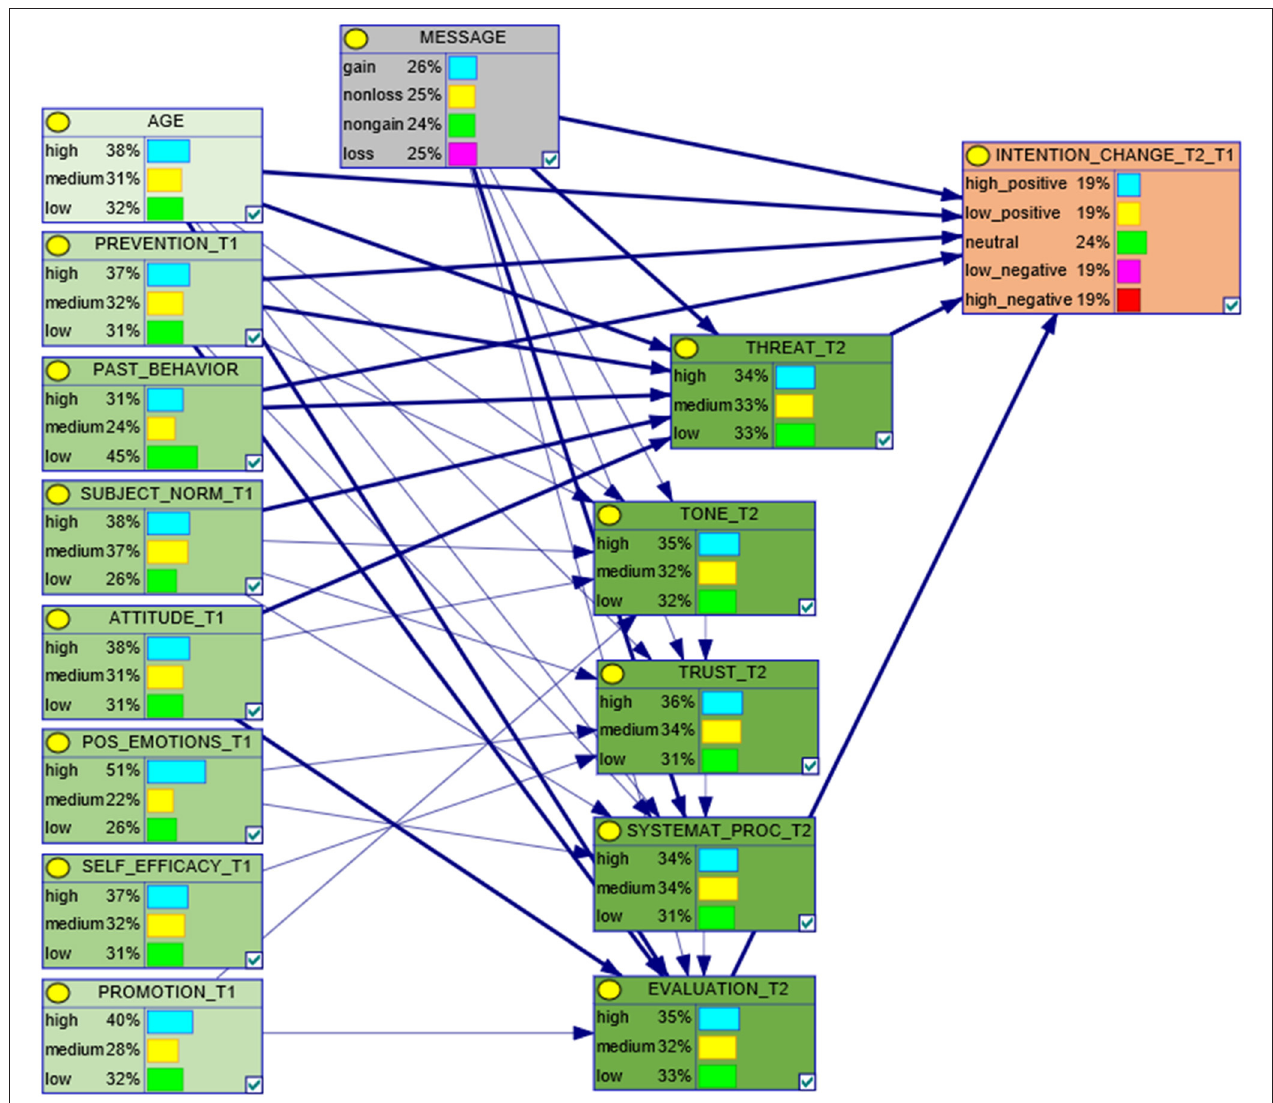
FIGURE 3 | The elicited DBN